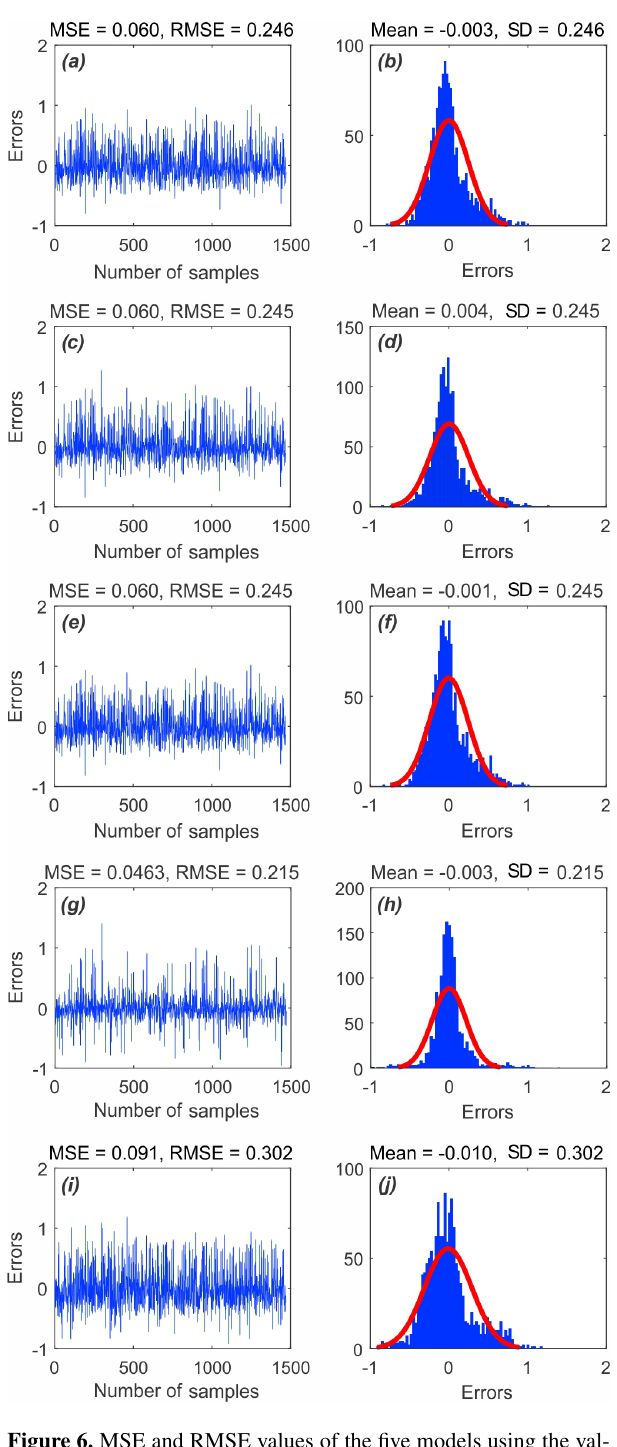
Figure 6. MSE and RMSE values of the five models using the val- idation dataset of (a) ANFIS–IWO, (c) ANFIS–DE, (e) ANFIS– FA, (g) ANFIS–PSO, and (i) ANFIS–BA. Frequency errors of the five models using the validation dataset of (b) ANFIS–IWO, (d) ANFIS–DE, (f) ANFIS–FA, (h) ANFIS–PSO, and (j) ANFIS– BA.